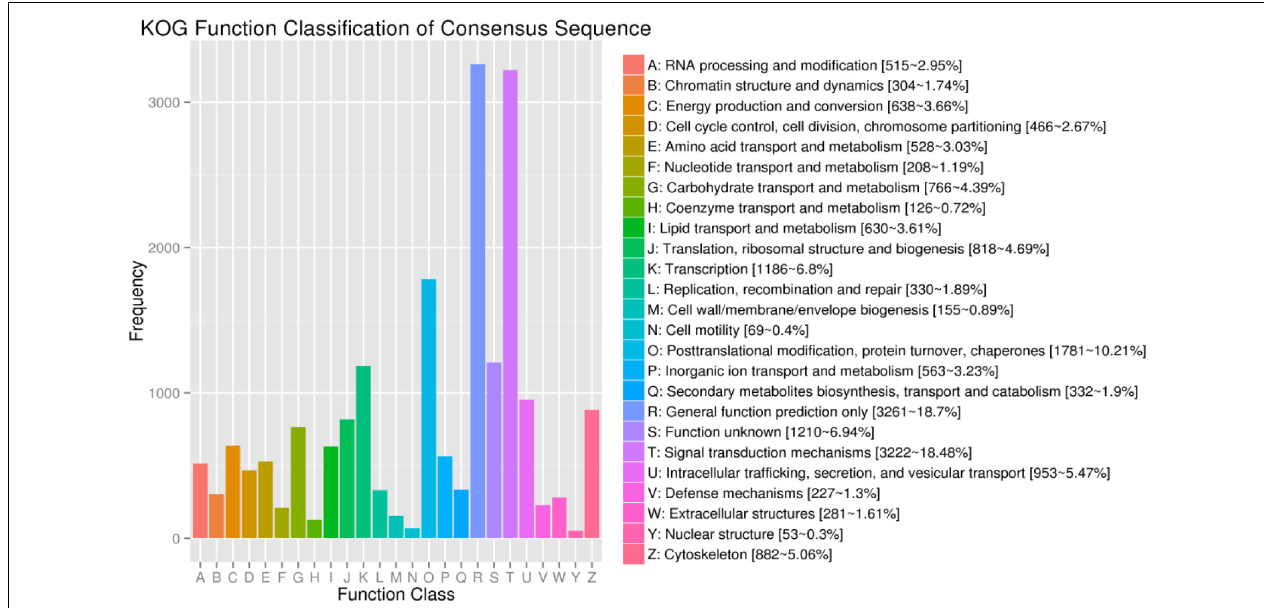
FIGURE 2 | The KOG function classification of assembled unigenes. X -axis: the function class of KOG, Y -axis: the frequency of unigens.